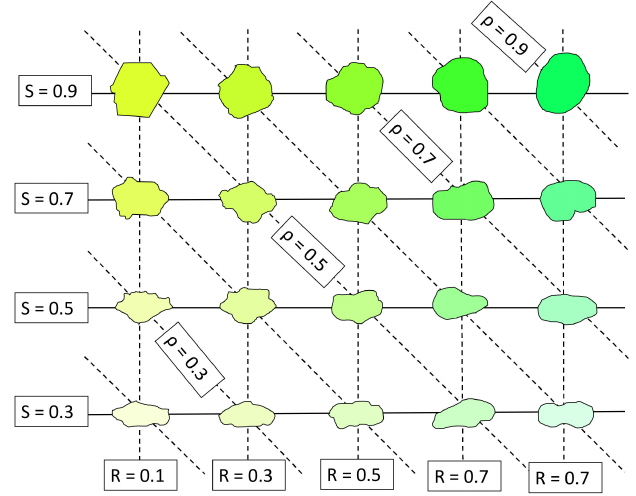
Figure 4. Particle shape characterization chart